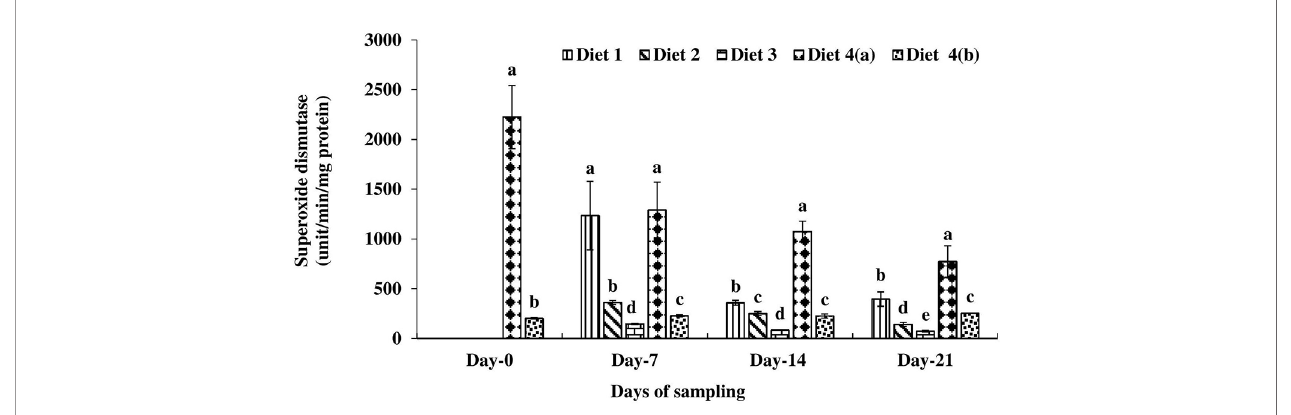
FIGURE 6 | Superoxide dismutase level found in four different diets fed UV-B exposed and unexposed Catla catla . Bars with different superscripts (a-e) are signi fi cantly different (n